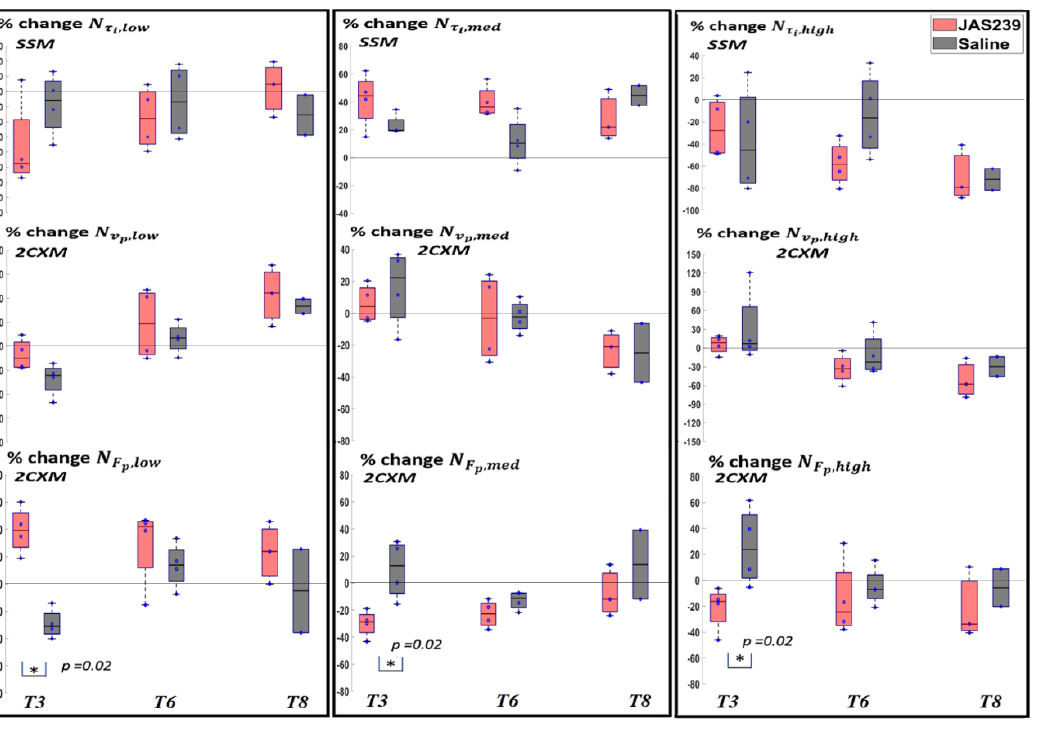
Figure 8. Box plot for percentage change (with respect to baseline) in 𝑁 𝜏 (where 𝑦 = low, med and high) ( top ) in F98 rat GBM with JAS239 (red) and saline (grey) treatment at different time points using the SSM model. The differences in the 𝑁 𝑣 using 2CXM model are shown in the middle and differences in the 𝑁 𝐹 using 2CXM model are shown in the bottom. The asterisk indicates significant difference.